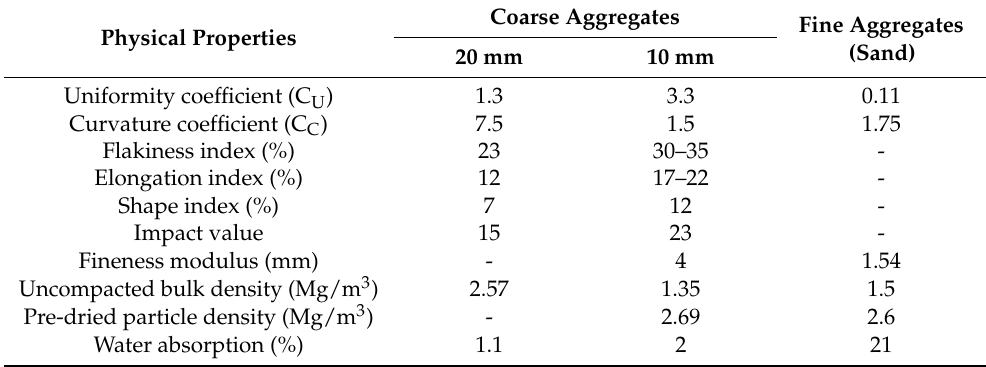
Table 3. Some physical properties of the coarse and fine